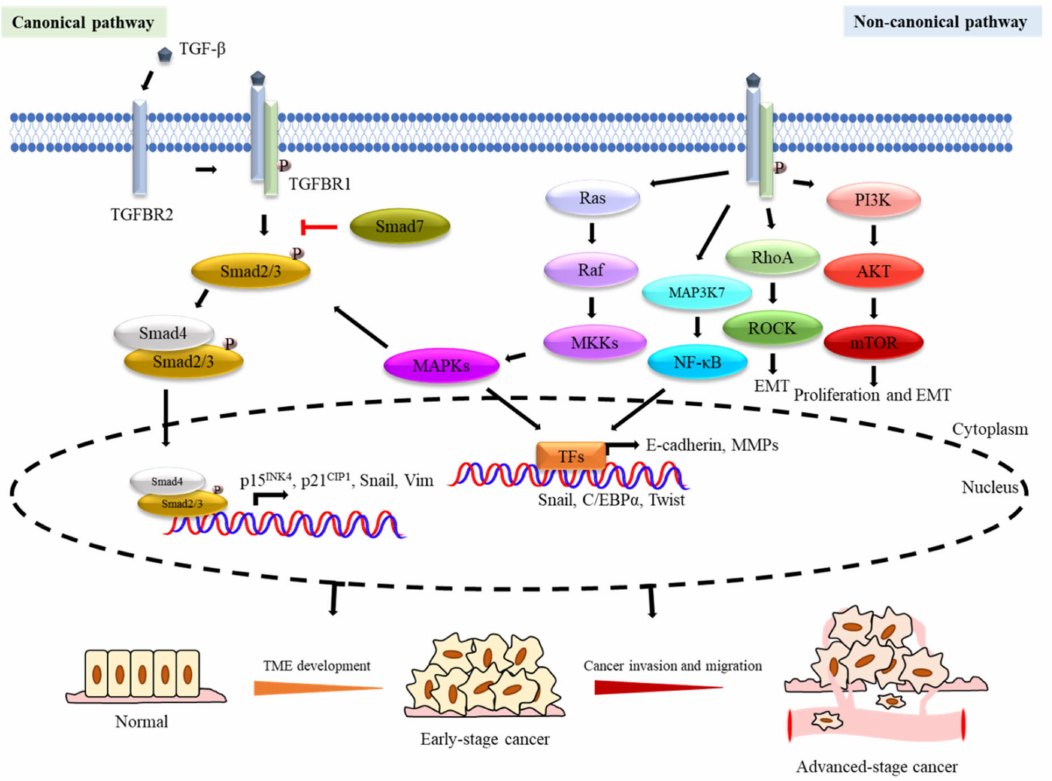
Figure 1. Transforming growth factor- β (TGF- β ) signalling pathways in tumorigenesis. The dual roles of TGF- β signalling pathways have been demonstrated in tumorigenesis. TGF- β is a tumour suppressor in TME development of early-stage cancer and a tumour promoter in malignancy processes of advanced-stage cancer. Schematic diagramme (above) showing TGF- β signalling and its role in cancer tumorigenesis and progression as well as tumour suppression. TGF- β binds to TGFBR2